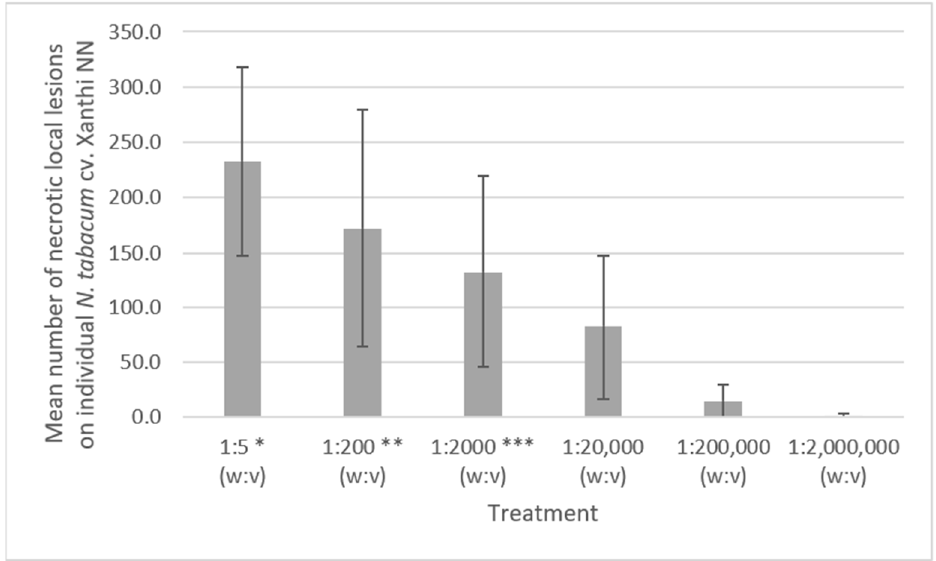
Figure 3. Mean number of necrotic local lesions on individual N. tabacum cv. Xanthi NN plant after mechanical inoculation of a dilution series, based on the inoculum Tomato brown rugose fruit virus (ToBRFV) sap used (infected N. clevelandii leaf:buffer 1:5 ( w : v ), up to 1:2,000,000 ( w : v ). n = 10. * equals the inoculum that was used to contaminate the fabrics; ** equals to the virus concentration found in the cleaning solutions, assuming that all ToBRFV particles could be dissolved out of the contaminated fabric; *** represents the virus concentration that was inoculated on the leaves as cleaning solutions, assuming that all ToBRFV particles were removed from the fabric and no inactivation of ToBRFV took place.